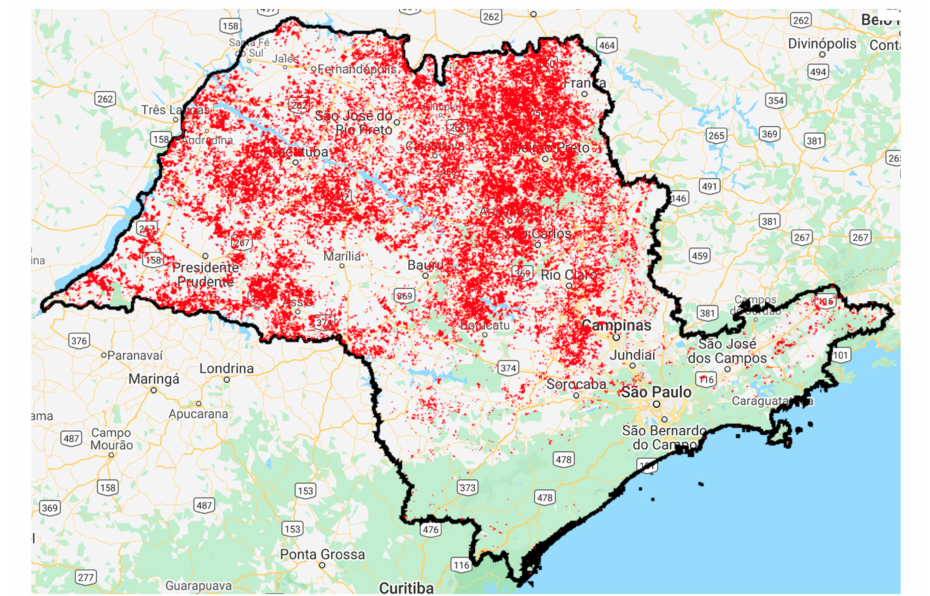
Figure 2. Moderate Resolution Imaging Spectrometer (MODIS) collection 6, version 6 burned area monthly global 500 m product for 2002–2017 filtered by the borders of S ã o Paulo State (black border). The red symbols indicate where fires were detected by the MODIS sensors. Throughout the course of the study period, 1,263,635,500 m pixels were burned, which were used to view corresponding MapBiomas land use